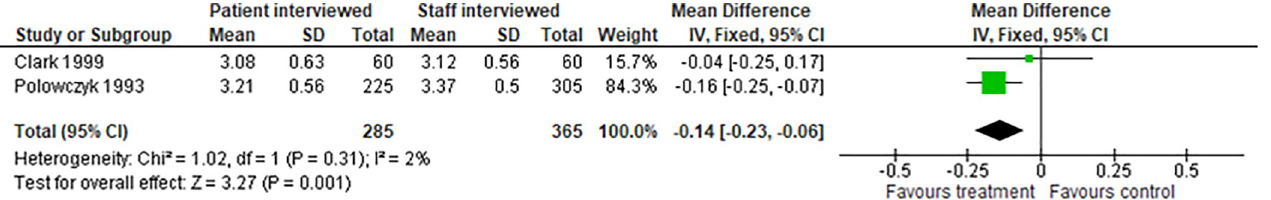
Fig 5. Meta-analysis of consumer engagement interventions for the outcome of